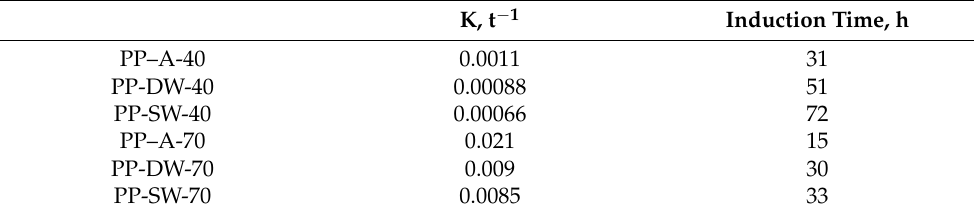
Table 2. Induction times and kinetic constants for the photo-oxidation of the polypropylene in all the environmental